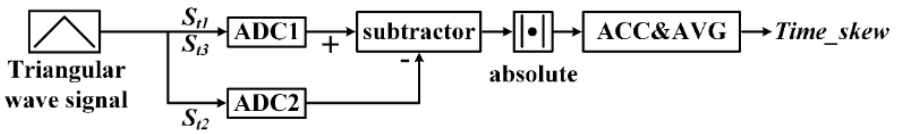
Figure 10. Time skew extraction diagram.